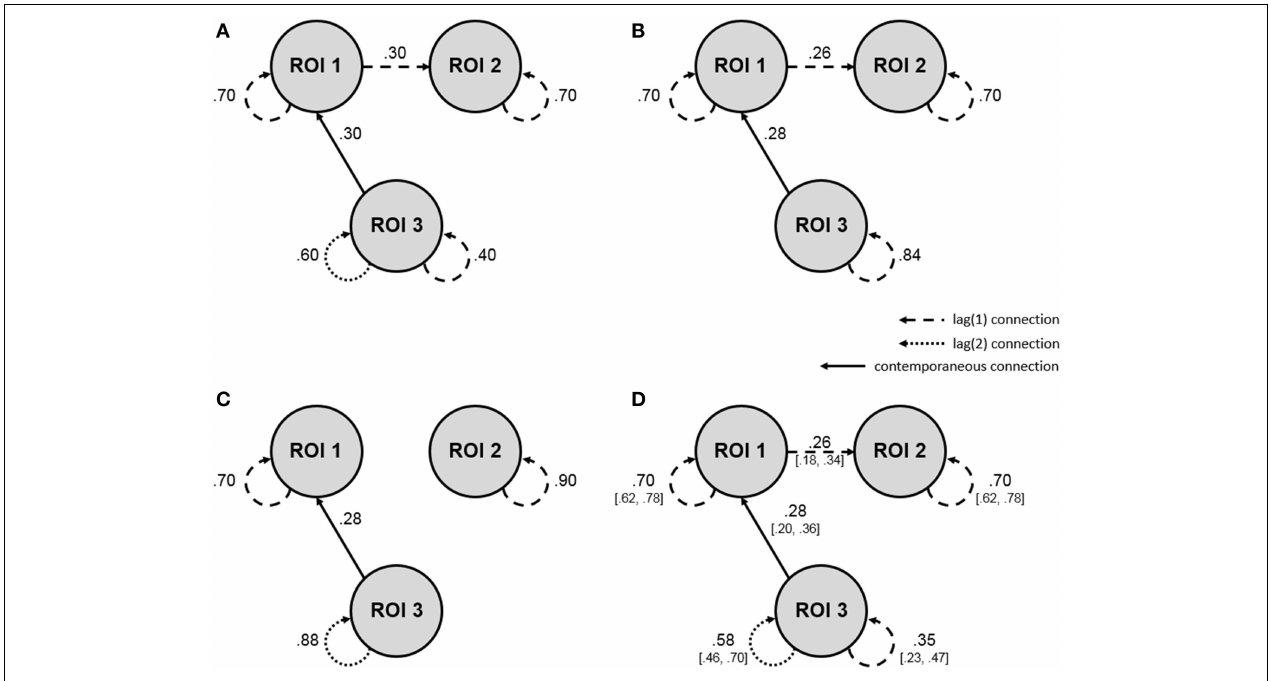
first order data-driven uSEM that did not contain white noise residuals. (C) Map resulting from a second order data-driven uSEM that did not contain white noise residuals. (D) Final map with white noise residuals resulting from the freeing of two additional confirmatory parameters, as indicated by modification indices from the second order data-driven uSEM white noise test. The final map precisely recovered the simulated map, with true parameter values falling within the bracketed 95% confidence intervals of the estimated beta-weights. See Table 1 for model fit and white noise test